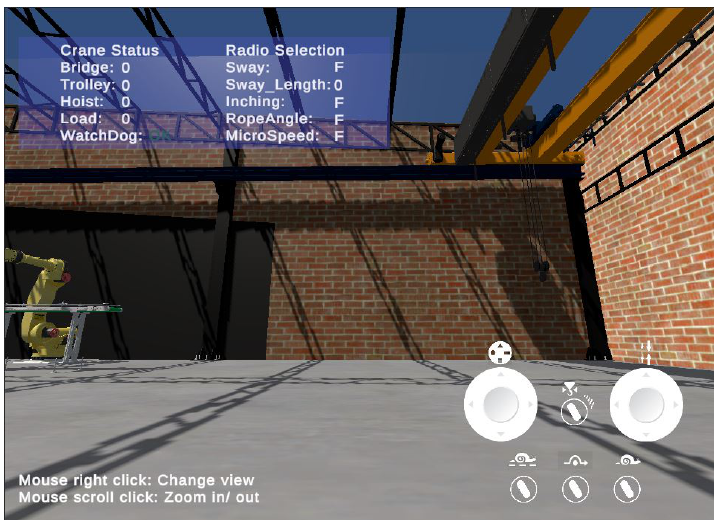
Figure 11. The screenshot of the remote control prototyping app. The 2D remote controller is located in the lower and right